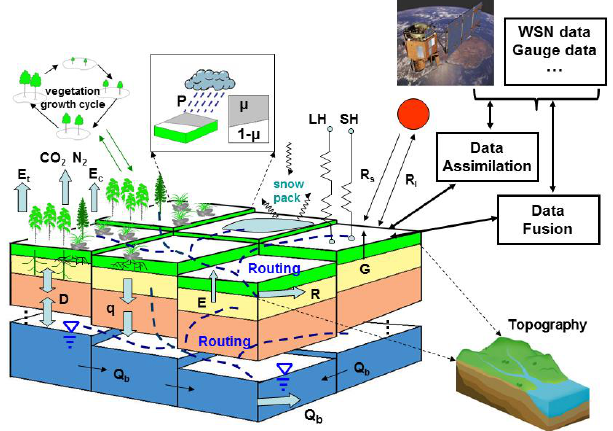
Figure 6. Hypothetical schematic of “next-generation” LSMs that will combine the desirable features of previous models, with the ad- dition of surface and subsurface hydrological routing schemes and representations of vegetation dynamics. Model–data fusion and data assimilation will allow effective use of observations from different platforms. Experience suggests that it will be a major challenge to achieve such a complex, realistic representation of land-surface bi- ology and hydrology without loss of reliability and robustness. The application of multiple physical and biological constraints, and the judicious use of stochastic parameterization for subgrid-scale pro- cesses, are advocated here as important tools for next-generation model development.